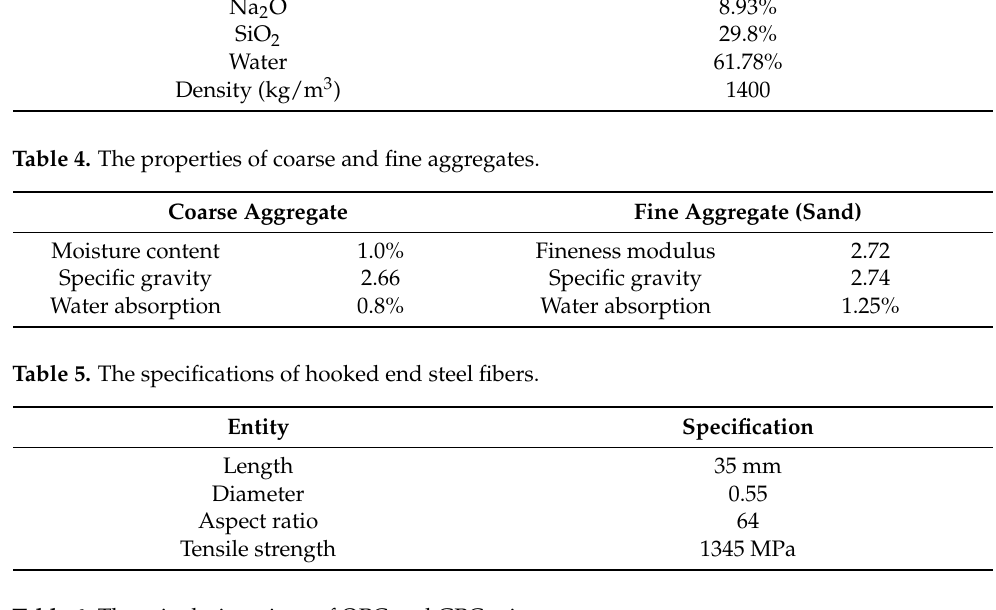
Table 6. The mix designations of OPC and GPC